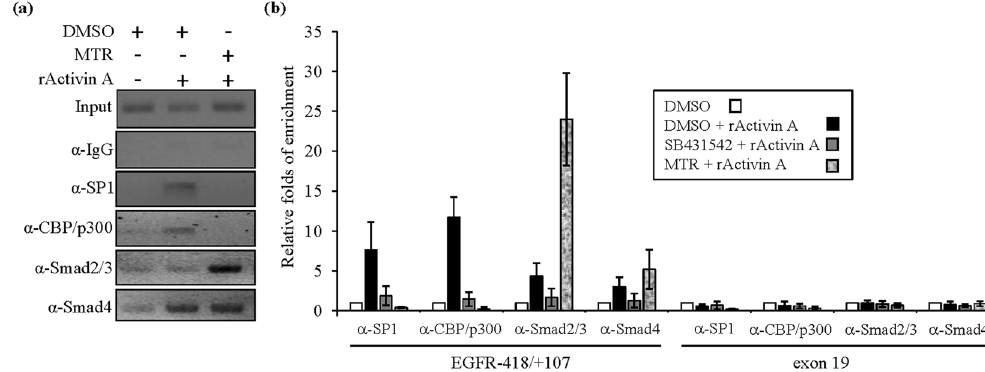
Figure 6. A transcriptional complex consisting of Smad2, Smad4, SP1, and CBP/p300 was recruited to the EGFR promoter in the presence of rActivin A as demonstrated by ChIP followed by quantitative real-time PCR. ( a ) The gel electrophoresis results for a ChIP assay followed by quantitative real-time PCR. ChIP DNA fragments bound by various antibodies were amplified by a specific primer targeting the EGFR proximal promoter ( − 418/ + 107), as measured by a ChIP assay followed by qRT-PCR, for which products were separated on a 2% agarose gel. ( b ) The results are expressed as the relative fold of enhancement for quantitative real- time PCR following the ChIP assay. OC3 were cells treated with vehicle (DMSO) with or without rActivin A or with inhibitors in the presence of rActivin A. Formaldehyde-fixed DNA was pulled down by various antibodies, followed by quantitative real-time PCR analysis. The EGFR exon 19 PCR served as a nonspecific control for the ChIP assay; an IgG control was also used as a negative control for the ChIP assay, while ChIP DNA fragment pull-down using α -acetyl-Histone 3 was a positive control for the active promoter in this assay (not shown in this figure). Calculations were performed as described in the Materials and